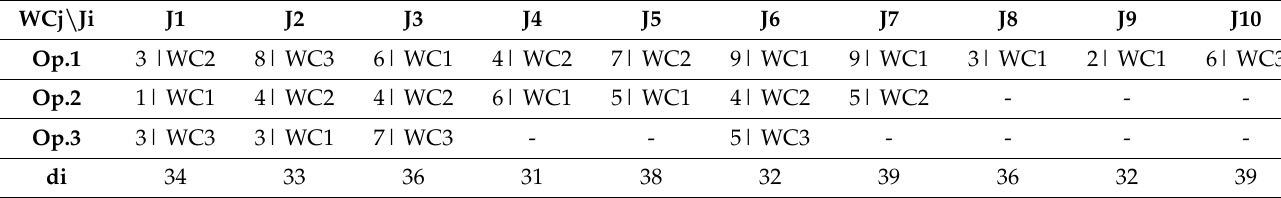
Table 3. Scheduling problem (instance 27)